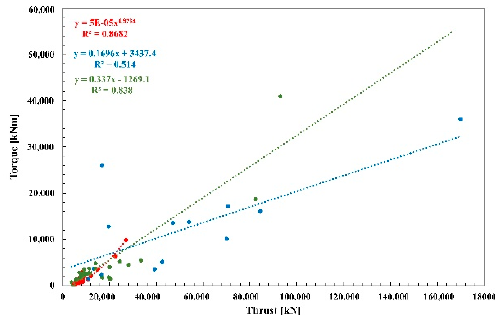
Figure 4. Correlation between thrust and torque. Red: open TBM; blue: single shield TBM; green: double shield TBM.